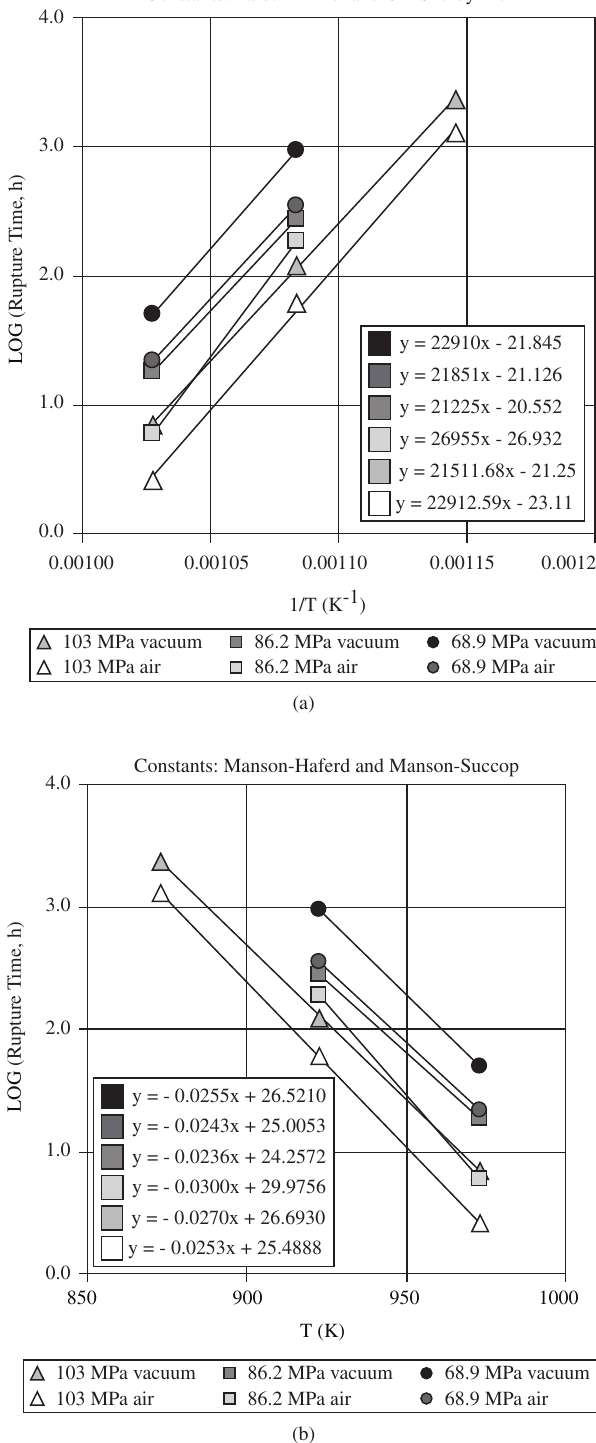
Figure 10. Variation of LOG (rupture time) with: a) inverse temperature; and b) temperature for 2.25Cr-1Mo steel, in air and